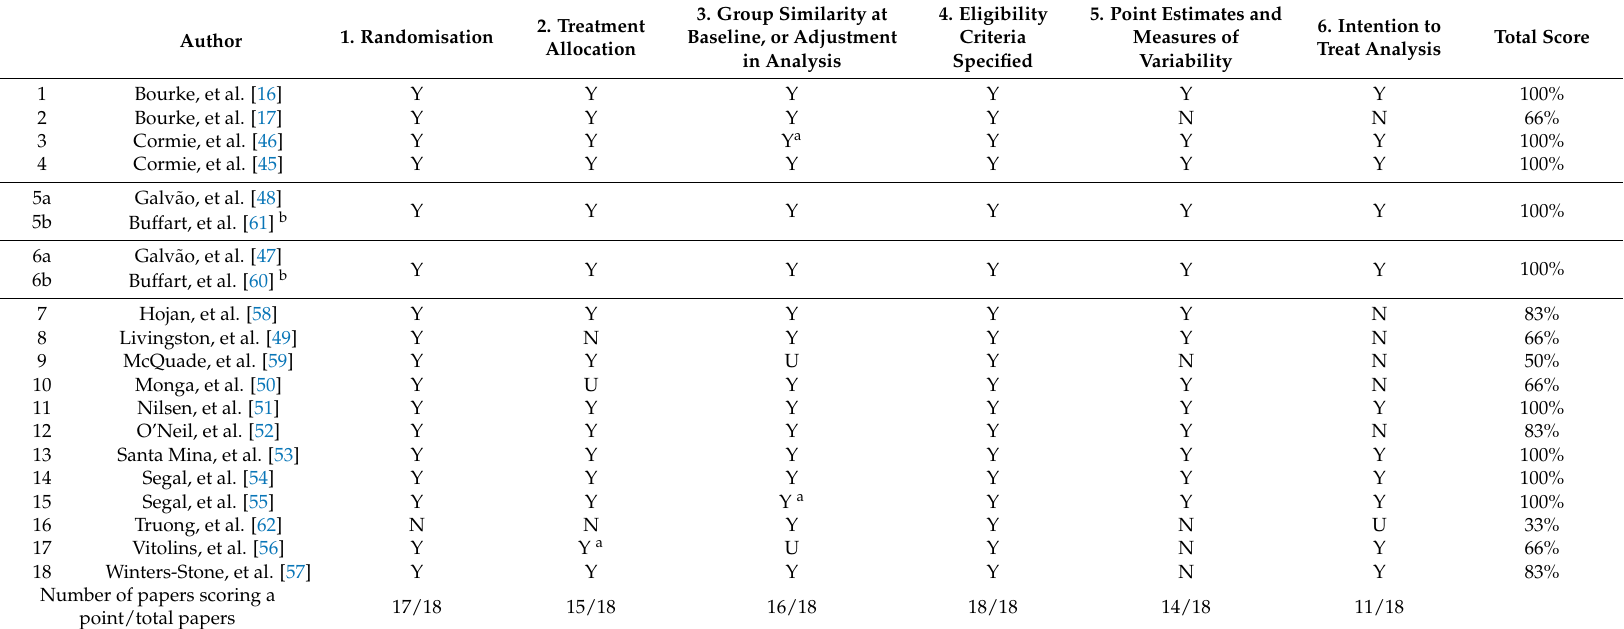
Table 2. Delphi quality rating